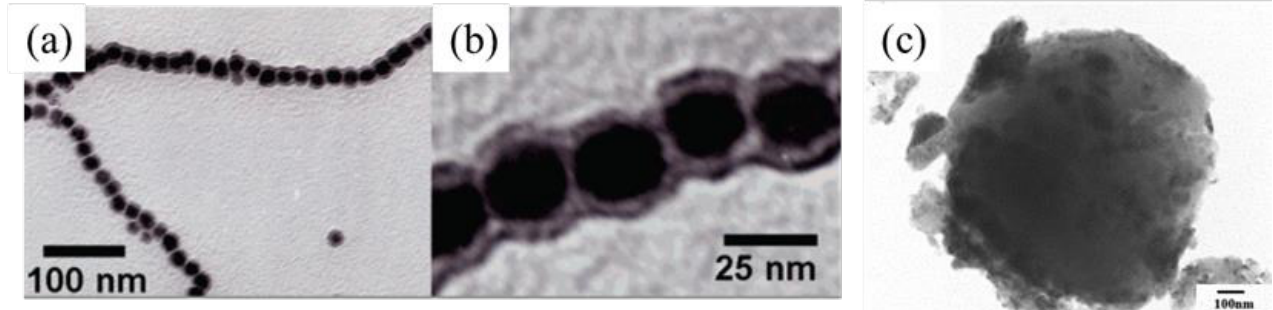
Figure 4. TEM images of magnetic polymer composites: ( a , b ) Co-PS nanoparticle chains (Korth et al. [67], ©American Chemical Society, 2006) and ( c ) Cu–Ni/polyethylene glycol magnetic polymer (Chatterjee et al. [68], Elsevier B.V.,